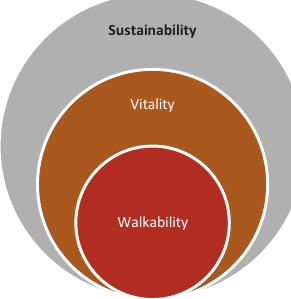
Figure 1. The relationship between vitality and walking (source: Shamsuddin et al., 2012, p.